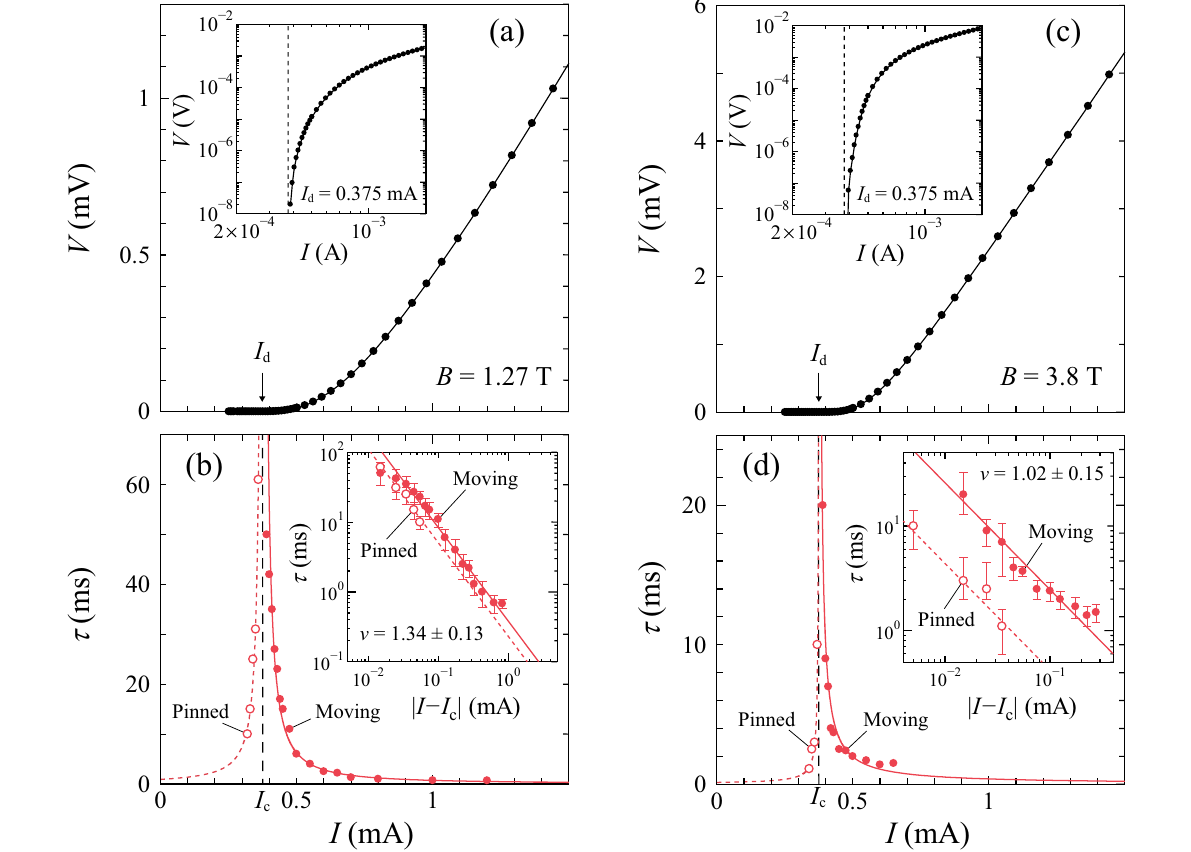
Figure 1. The critical divergence of the relaxation time τ( I ) at the current-driven depinning transition ( I c ). ( a , c ) I – V characteristics at 4.1 K in ( a ) 1.27 T and ( c ) 3.8 T on a linear-linear scale. Inset: I – V data plotted on a log–log scale. A vertical arrow and dashed line in each main panel and inset, respectively, indicate the depinning current I d = 0.375 mA defined using a 10 − 8 V criterion. Other lines are guide to the eye. ( b , d ) The critical divergence of τ( I ) at the I -driven depinning transition in ( b ) 1.27 T and ( d ) 3.8 T. The open and solid red circles represent τ for I 0.37 mA and I 0.39 mA, respectively, showing a power-law divergence at 0.375 ± 0.005 ≤ ≥ I c ) from both sides, as marked with a vertical dashed line. Inset: log τ versus log mA( ≡ ( d ) 3.8 T, where symbols are the same as in the main panel. Both the dotted and full red lines indicate the power- ν with ( b ) ν = 1.34 ± 0.13 and ( d ) ν = 1.02 ± 0.15. The error bars in τ mainly correspond I I c law fits by τ ∝ | − | − to the fitting errors resulting from the uncertainty in determining a